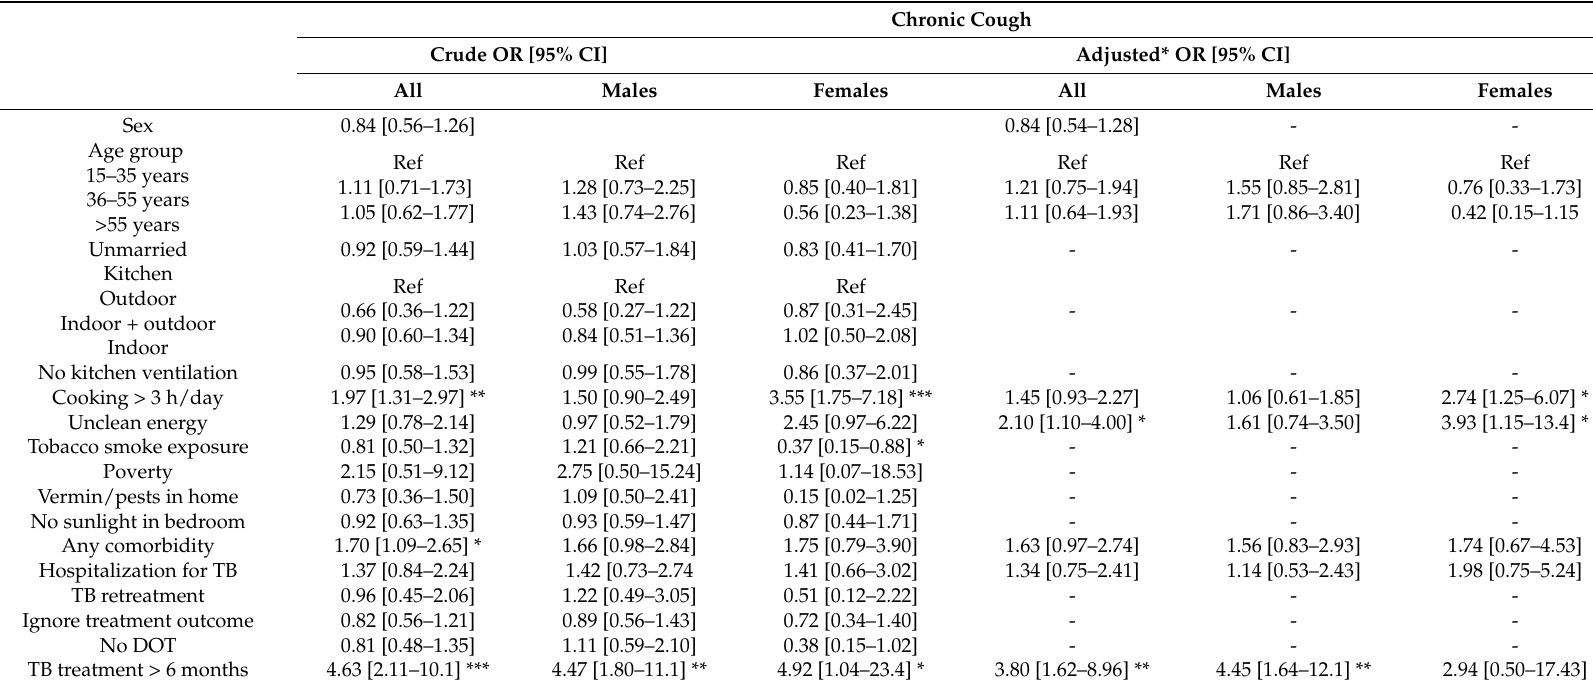
Table 3. Crude and adjusted effects of HAP and other predictors on chronic cough among survivors of pulmonary TB, overall and by